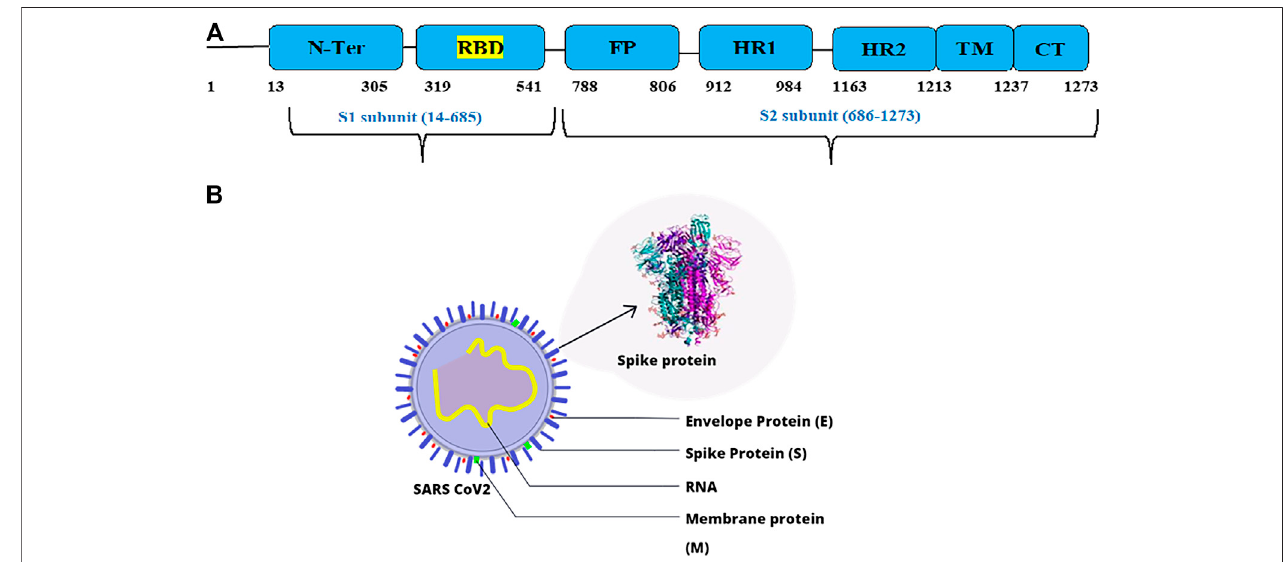
FIGURE 1 | (A) Domains of S glycoprotein. (B) Structure of SARS-CoV-2.